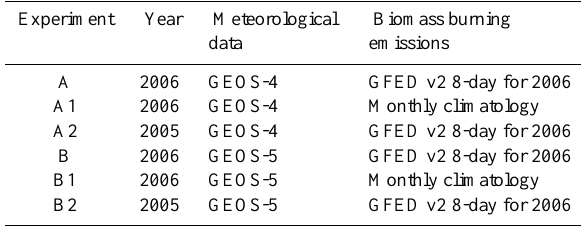
Table 1. Description of model